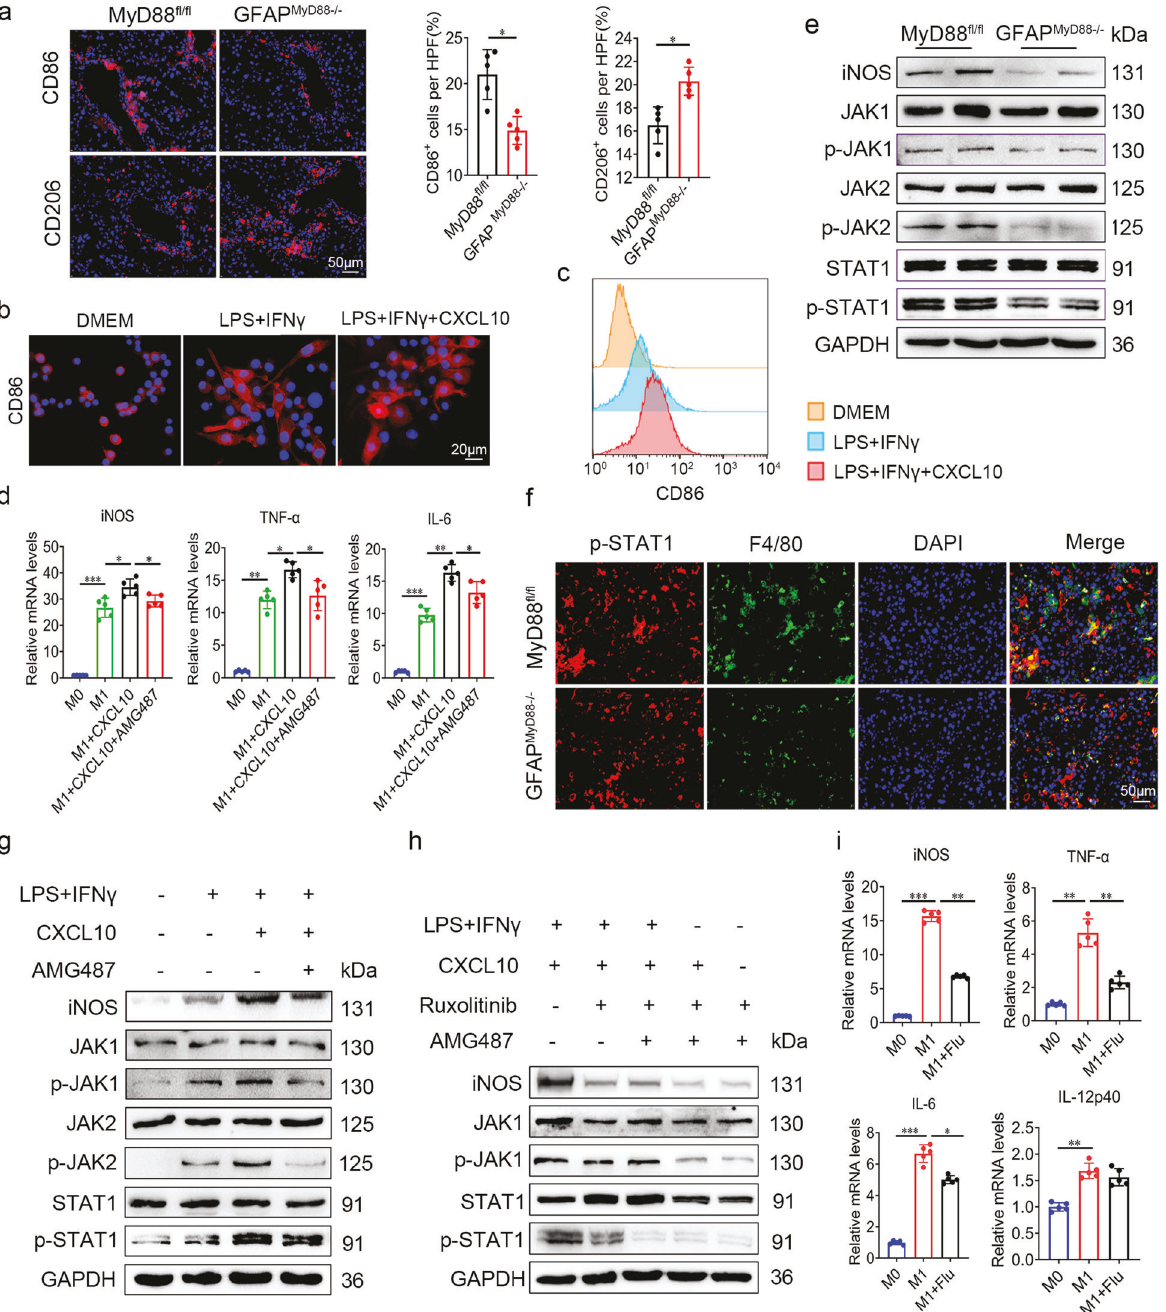
Fig. 6 CXCL10 promotes M1 polarization in macrophages via activating JAK/STAT1 pathway. a Immuno fl uorescence staining for CD86 and CD206 in liver tissues of CCl 4 induced MyD88 fl / fl , GFAP MyD88 − / − mice and statistical analysis. Scale bar, 50 μ m. * p < 0.05. RAW264.7 cells was induced by LPS and IFN γ , 10ng/mL CXCL10 recombinant protein. b Immuno fl uorescence staining for CD86 in Raw264.7 cells. c Flow cytometry analysis of the proportion of CD86 + cells treated with LPS, IFN γ and CXCL10 recombinant protein. d RAW264.7 cells was induced by LPS and IFN γ ,